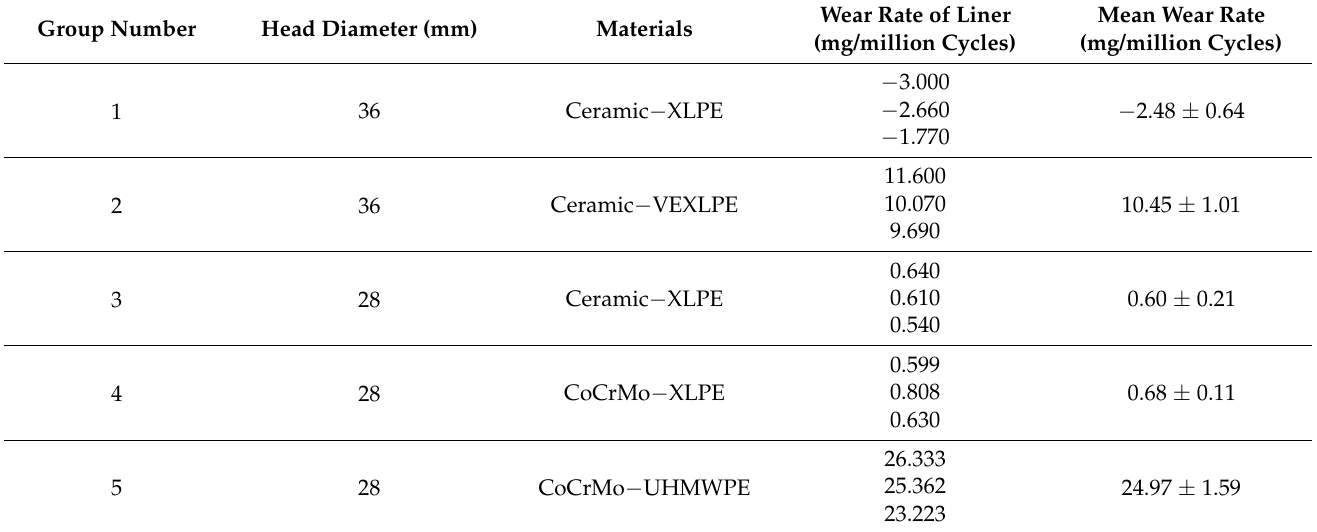
Table 2. Wear rate after 5 × 10 6